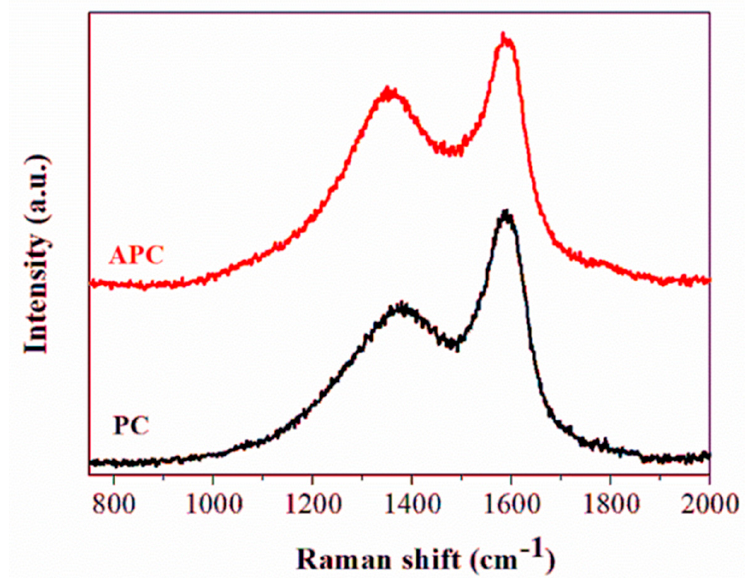
Figure 4. Raman spectra of PC (black line) and APC (red line), showing the characteristic D and G carbon bands from left to right.